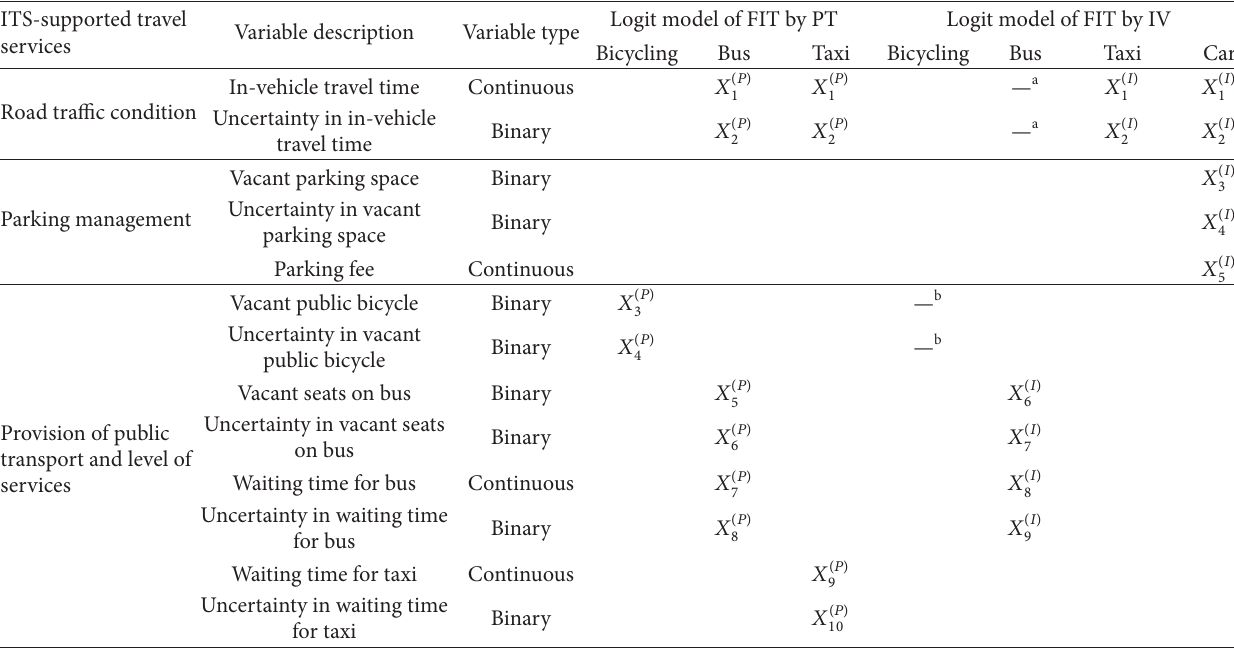
Table 1: ITS-related variables in Mixed Ranked Logit Model for different types of